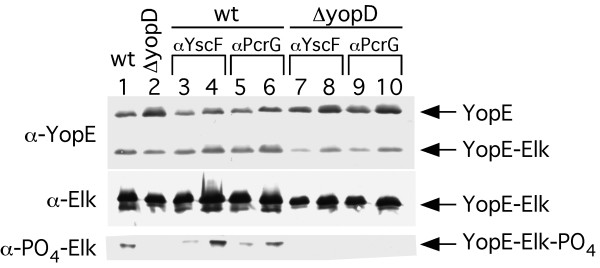
Y. pestis strain KIM8-3002 (wt) (lane 1 and lanes 3–6) and KIM8-3002.2 (ΔyopD) (lane 2 and lanes 7–10) both containing plasmid pYopE129-Elk were used to infect HeLa cells at an MOI of 10. 4 h following infection the culture supernatant containing non-adherent bacteria were removed the remaining adherent HeLa cells were solubilized in 2X SDS-PAGE buffer. Following solubilization proteins were separated and immunoblotted to triplicate PVDF membranes. The triplicate blots were probed with α-YopE, α-Elk, or α-PO4-Elk, followed by incubation with an alkaline phosphatase conjugated secondary antibody and developed using NBT/BCIP. To some samples anti-sera specific for HT-YscF (lanes 3–4 and lanes 7–8) or the Pseudomonas protein, PcrG (lanes 5–6 and lanes 9–10), were added at dilutions of 1:10 (lanes 3, 5, 7, and 9) or 1:25 (lanes 4, 6, 8, and 10).